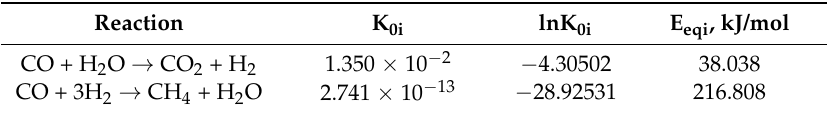
Table 6. Equilibrium constants calculated by the van’t Hoff equation.